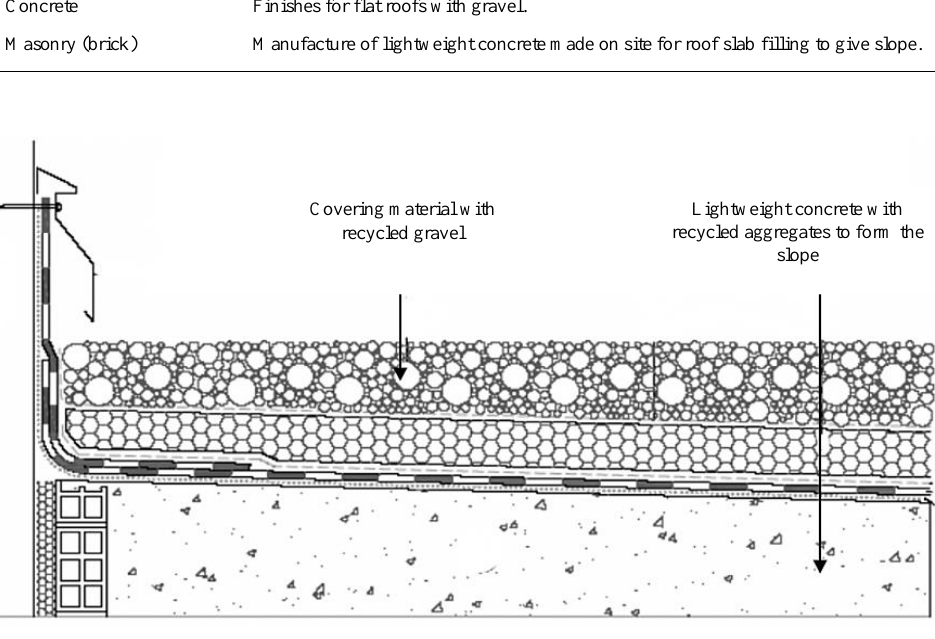
Figure 4. CDW generated at the construction site.